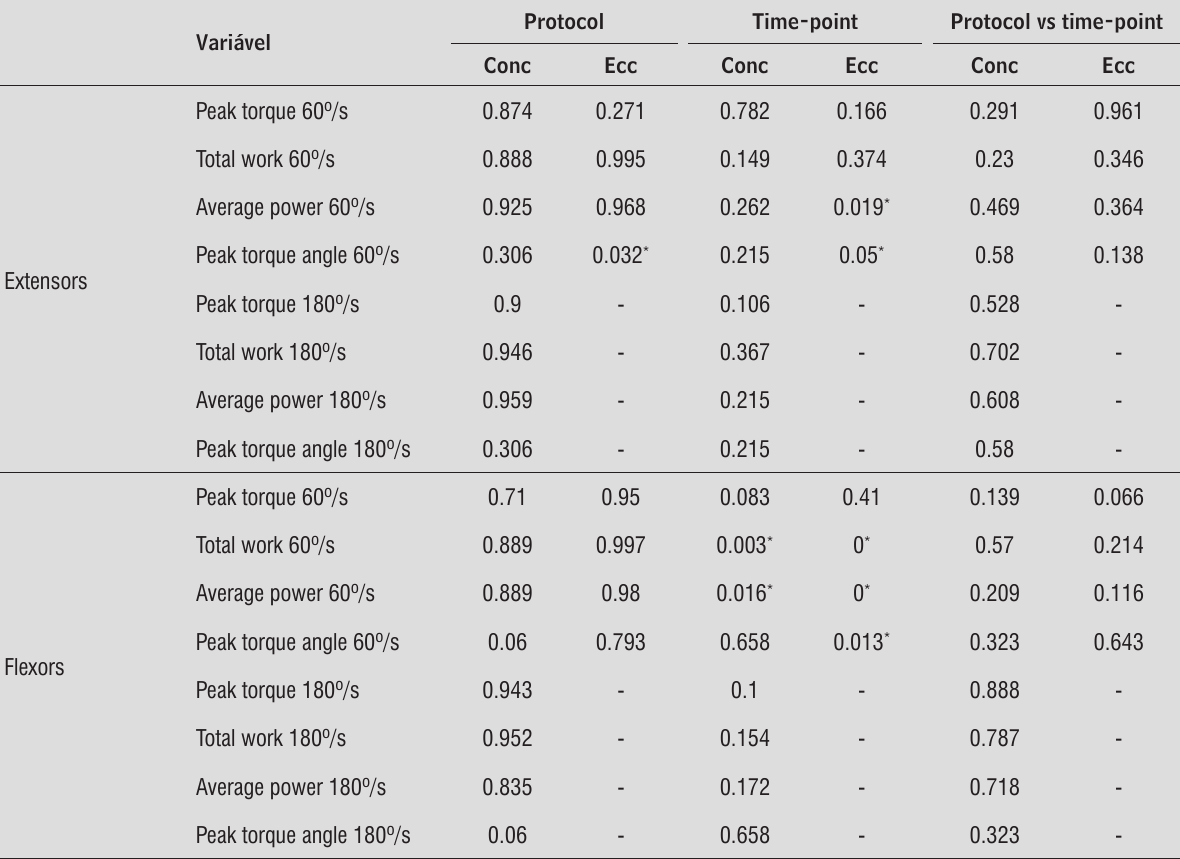
Table 4 - Summary of the results of the statistical